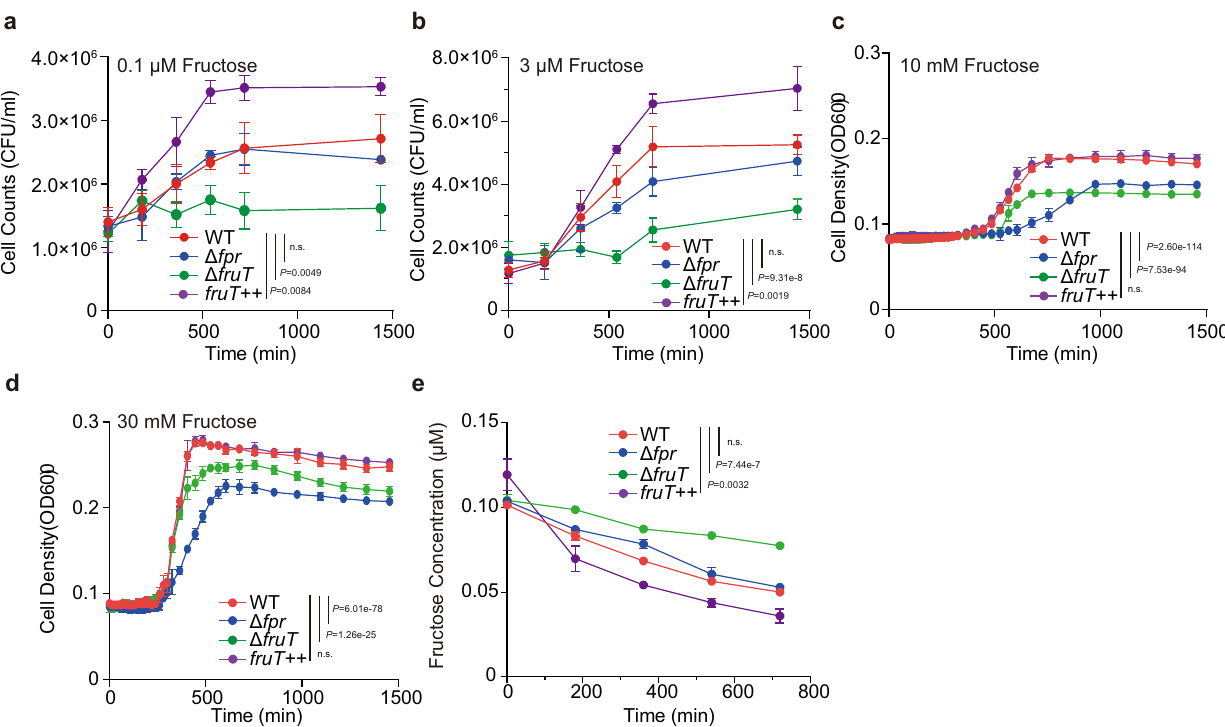
Fig. 5 FruT is responsible for the bacterial uptake of fructose at low concentrations in seawater. a – d Growth curves of WT, Δ fruT , Δ fpr , and fruT ++ in M9 medium containing 0.1 μ M ( a ), 3 μ M ( b ), 10 mM ( c ), 30 mM ( d ) fructose as the only carbon source under aerobic conditions. Cell growth was followed by plating and determining the cell counts on LB agar plates ( a , b ) or measuring the absorbance at 600 nm ( c , d ). Data represent the mean ± SD ( n = 3). e Fructose consumption by WT, Δ fruT , Δ fpr , and fruT ++ grown in M9 medium containing 0.1 μ M fructose as the only carbon source. Data represent the mean ± SD ( n = 3). Signi fi cance is determined by two-way ANOVA and indicated as the P value; n.s. means no signi fi cant difference. Source data are included in Source Data fi low-concentration fructose under aerobic conditions. In contrast, Δ fruT exhibited the same survival ability as WT when growing